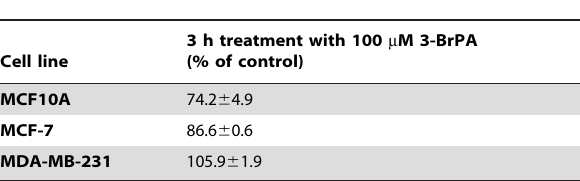
Table 1. 3-BrPA effects on HK activity from breast cell